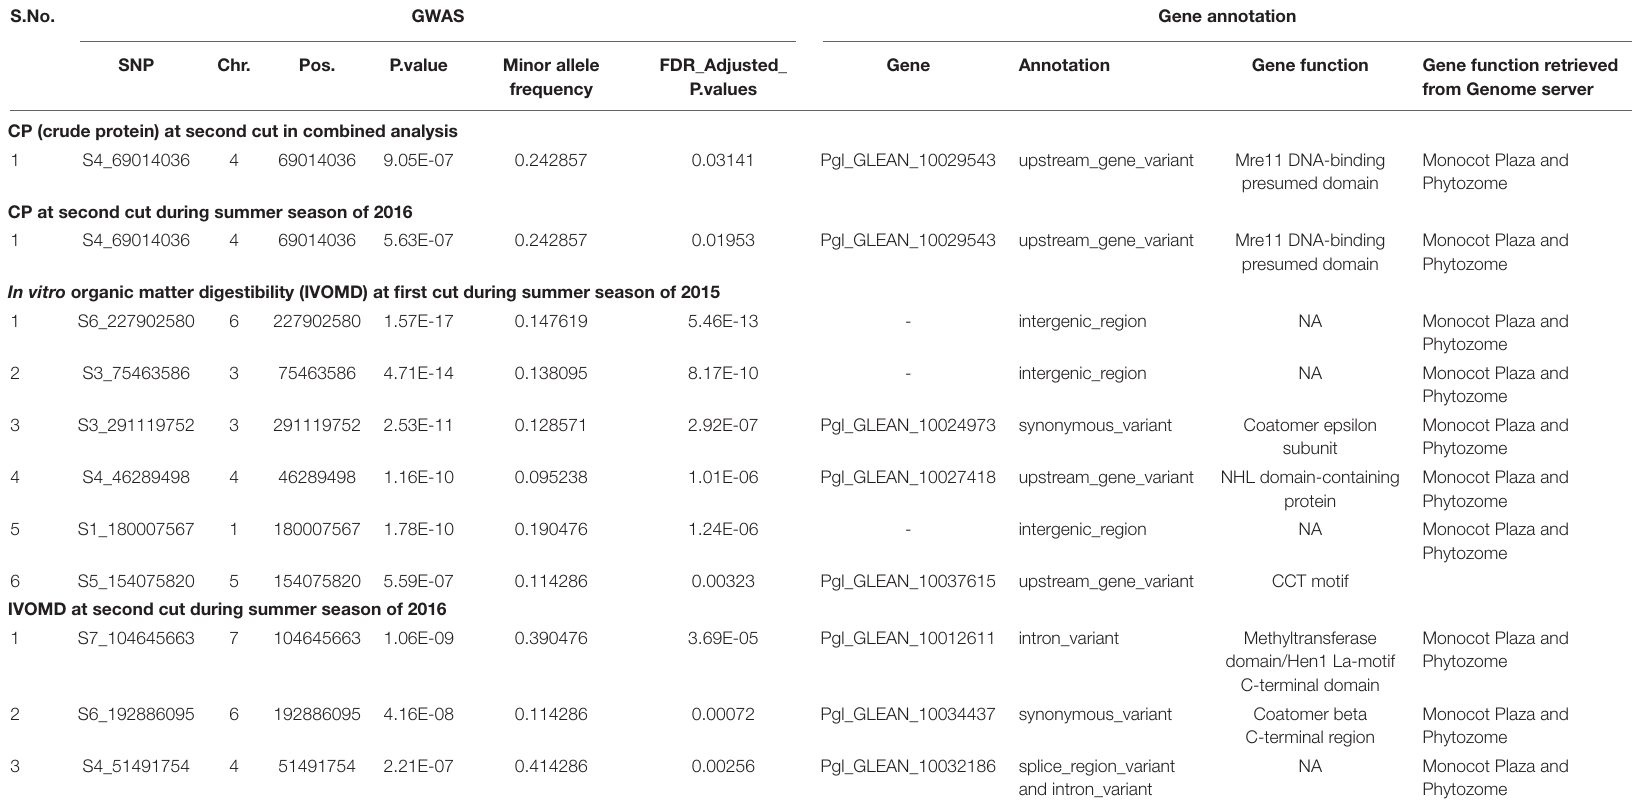
TABLE 5 | The traits linked markers, genes, and their functions identified for the forage quality traits in 105 hybrid parents evaluated during the summer seasons of 2015 and 2016 at ICRISAT, Patancheru. S.No. GWAS Gene annotation SNP Chr. Pos. P.value Gene